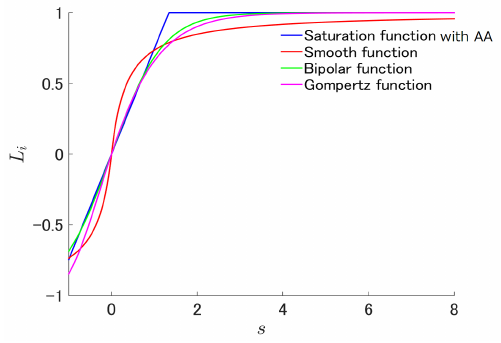
Figure 9. Candidate functions on icy